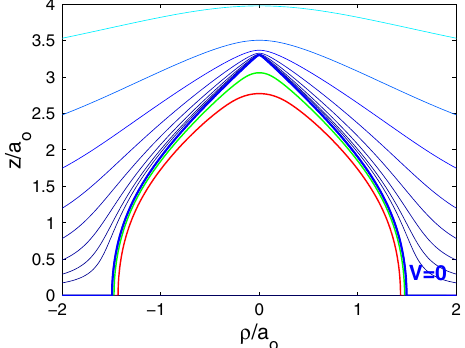
FIG. 1. Protrusions constructed with three different values of N . Increasing N results in sharper tips and thus higher enhance- ment factors. The three thick lines with different colors describe the shapes of the following protrusions. Red: r ¼ 0 : 7 , N ¼ 4 , (cid:5) ¼ 8 : 0 ; green: r ¼ 0 : 7 , N ¼ 6 , (cid:5) ¼ 12 : 4 ; blue: r ¼ 0 : 7 , N ¼ 12 ; , (cid:5) ¼ 44 : 3 Also shown is the contour plot of the electric potential obtained by using the point charge model for r ¼ 0 : 7 , N ¼ 12 . V ¼ 0 marks the zero equipotential line which con- stitutes the shape of the protrusion. V 0 ; z 0 . For example, if we have the model with a n ð n þ 1 Þ ¼ single dipole , N ¼ 1 , to find (cid:4) 1 , we demand V 1 ð 0 ; z 2 Þ ¼